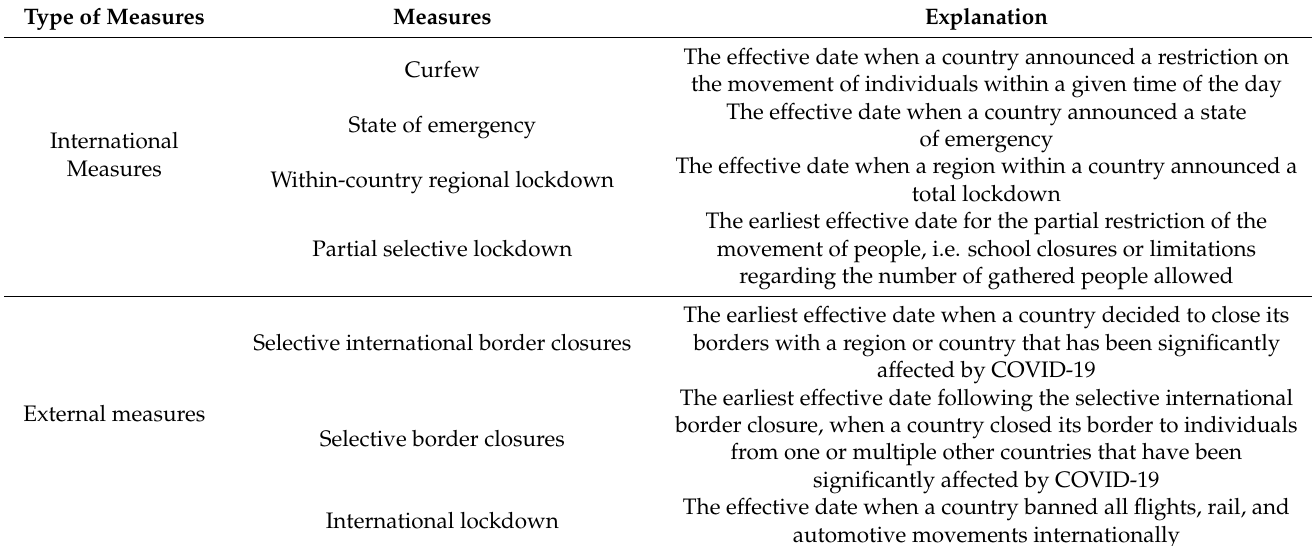
Table 1. Lockdown policies implemented worldwide adapted from